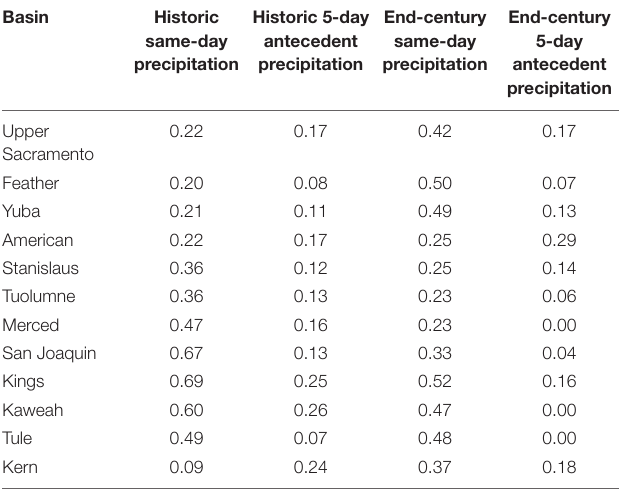
TABLE 5 | Coefficient of determination for relationship between extreme runoff (at or above the 99th percentile) and precipitation, both for same-day precipitation and accumulated precipitation for 5 days prior to the extreme runoff